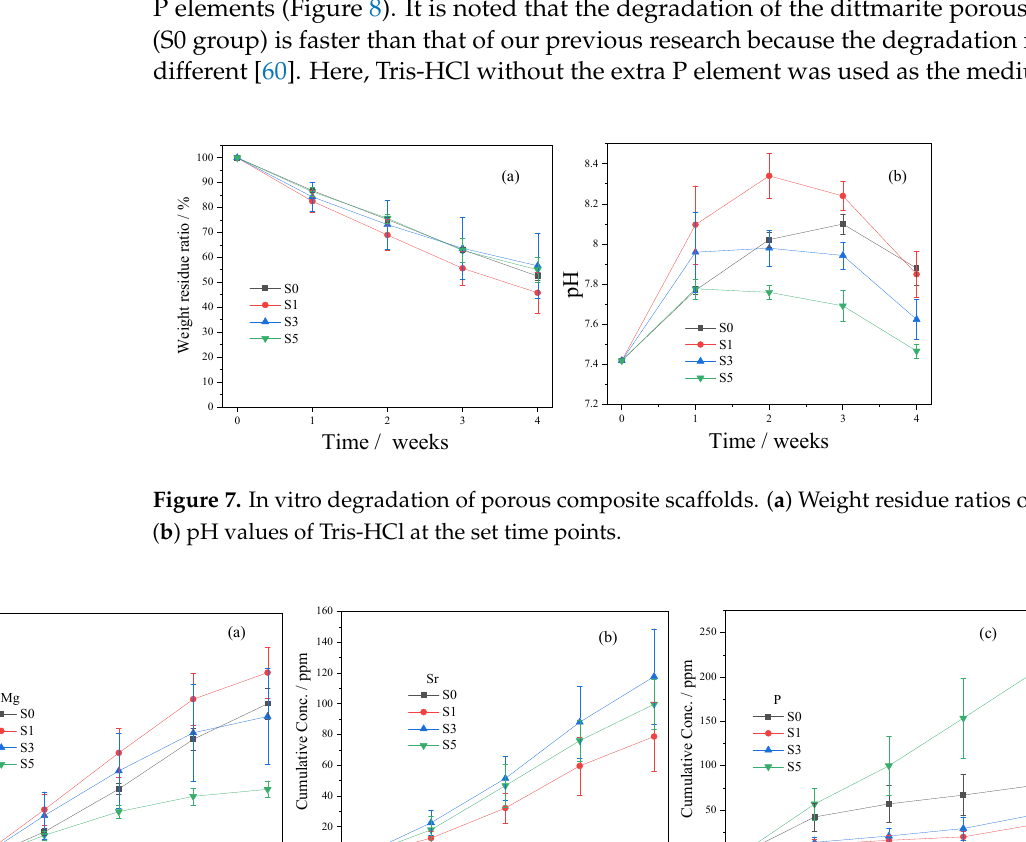
Figure 6. Relative radiopacity of MgNH 4 PO 4 ·H 2 O/SrHPO 4 porous composite scaffolds calculated by image analysis with respect to an aluminum standard. Different small letters represent statistically significant differences ( p < 0.05), whereas the same small letters represent non-statistically signifi- cant differences ( p > 0.05).